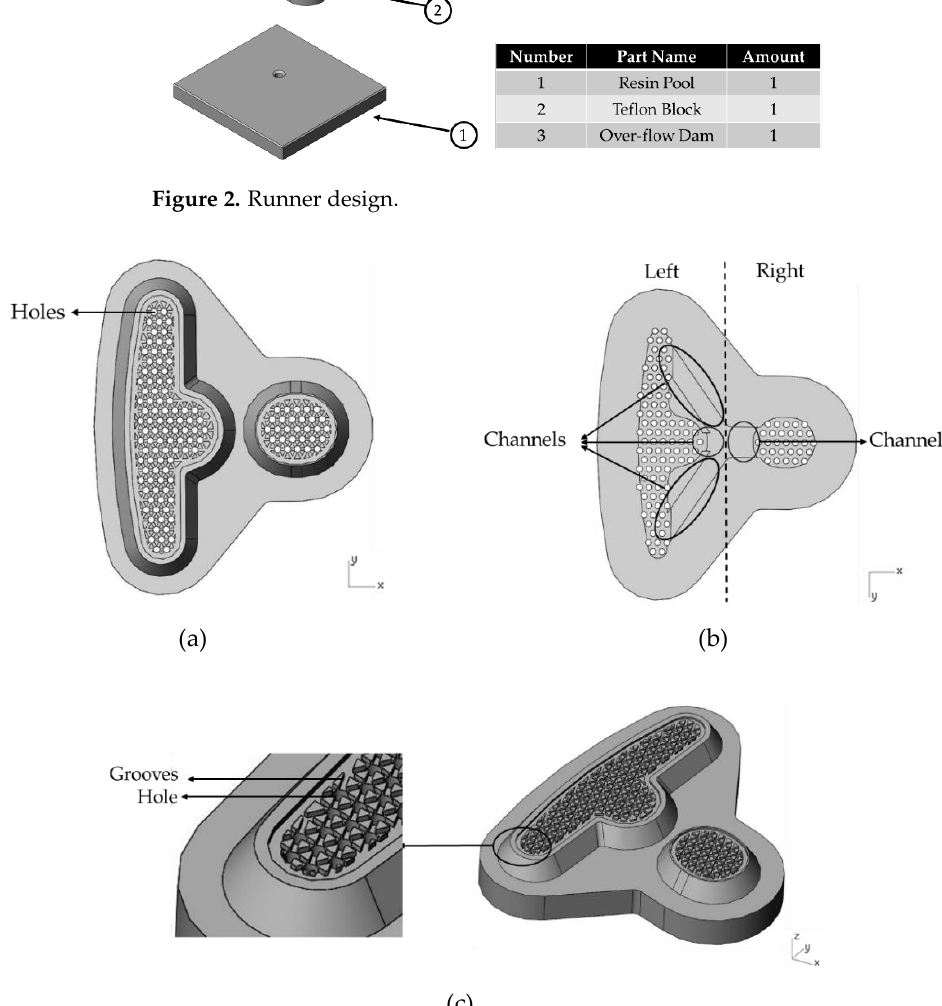
Figure 3. The design of the Teflon module. ( a ) Top view of the Teflon block. ( b ) Bottom view of the Teflon block. ( c ) The microstructure of the Teflon block.